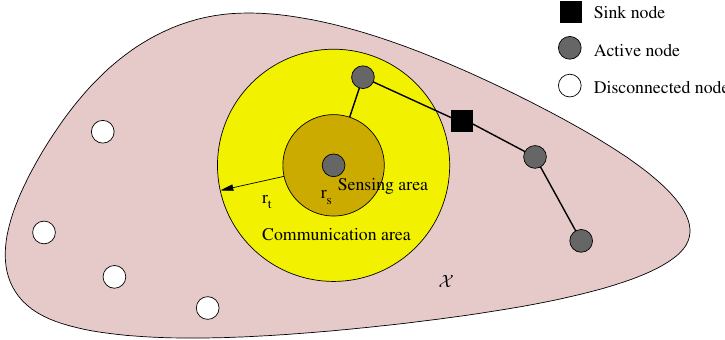
Figure 1. Connectivity and sensing